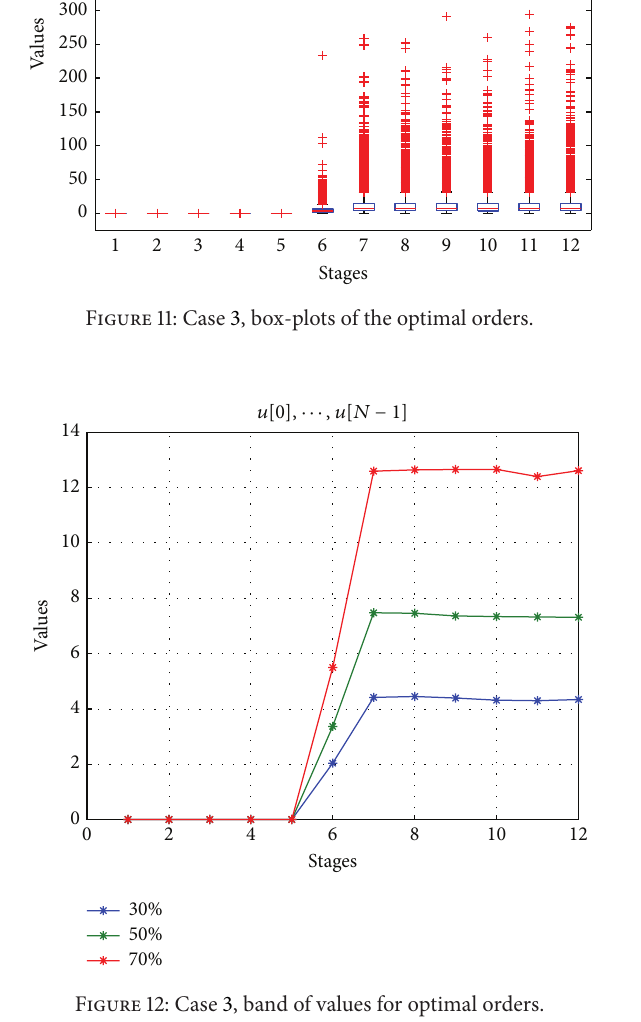
Figure 12: Case 3, band of values for optimal orders.